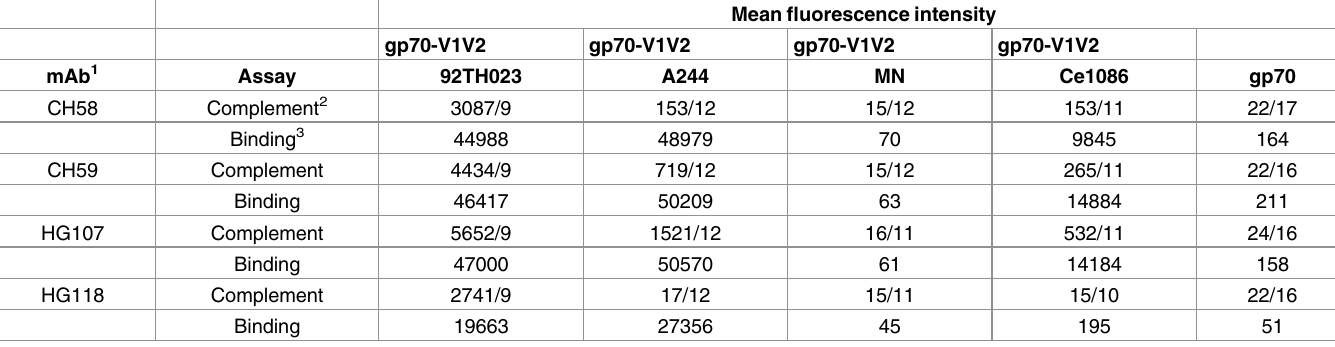
Table 1. V1V2-specific monoclonal antibodies from RV144 activate